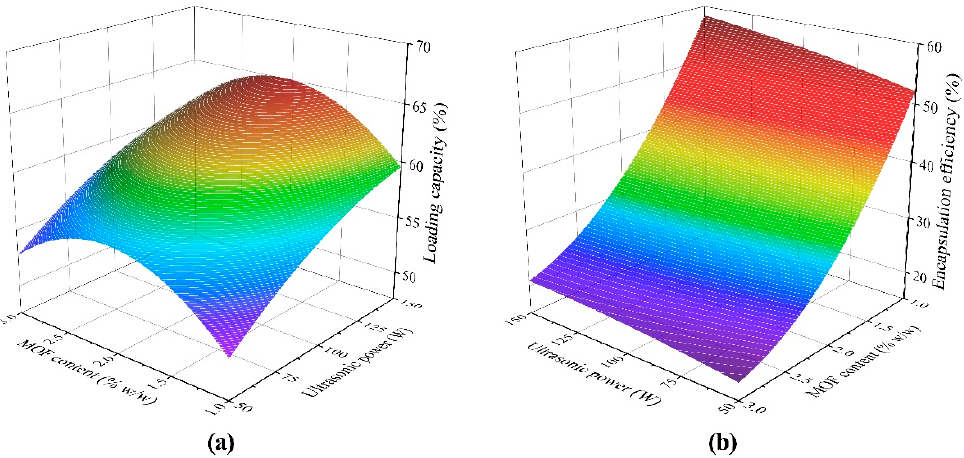
Figure 1. Response surface plot showing the effect of ultrasonic power and MOF content on ( a ) loading capacity (LC); ( b ) encapsulation efficiency (EE).